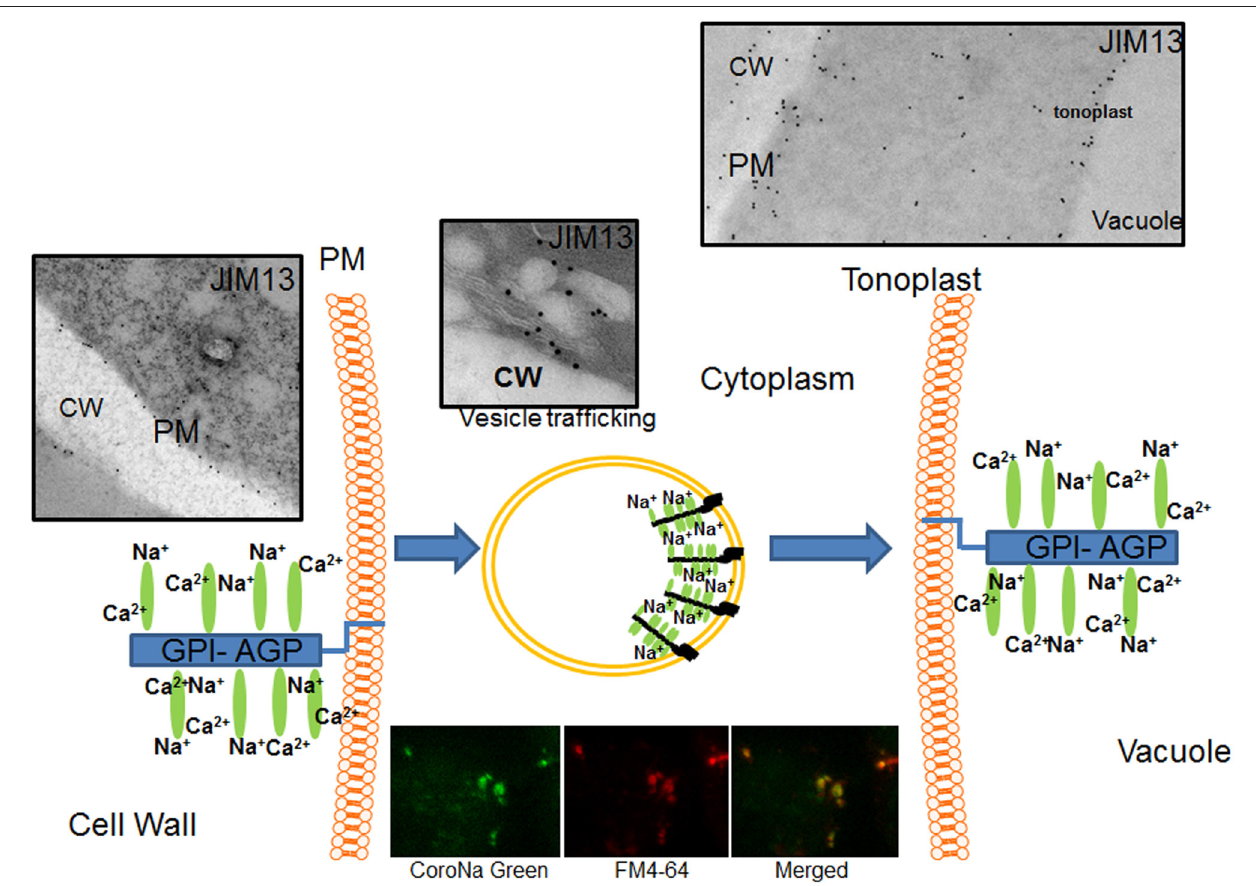
FIGURE 9 | Proposed model of AGPs as sodium carrier from the apoplast to the vacuoles in salt-adapted tobacco cells. AGPs bind calcium at the plasma membrane but it was partially removed by high sodium concentration in the apoplast. Plasma membrane linked AGPs are internalized by endocytosis transporting sodium by vesicle trafficking to the tonoplast and then liberating sodium in the vacuole. Sodium was located using the fluorochrome Asante Natrium-Green and vesicles were labeled using FM4-64. Cw, Cell Wall; Pm, Plasma